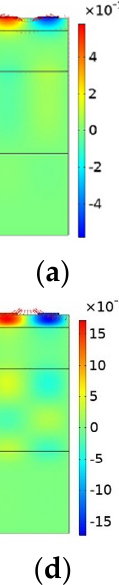
Figure 5. The acoustic wave modes shapes and their X-component of displacement ( μm ). ( a – c ) Anti-resonance of Rayleigh mode. ( d – f ) Anti-Resonance of Sezawa mode. ( a , d ) When ℎ (cid:2869) /𝑎 = 0.6 . ( b , e ) When ℎ (cid:2869) /𝑎 = 0.8 and ( c , f ) when ℎ (cid:2869) /𝑎 = 1.0 .